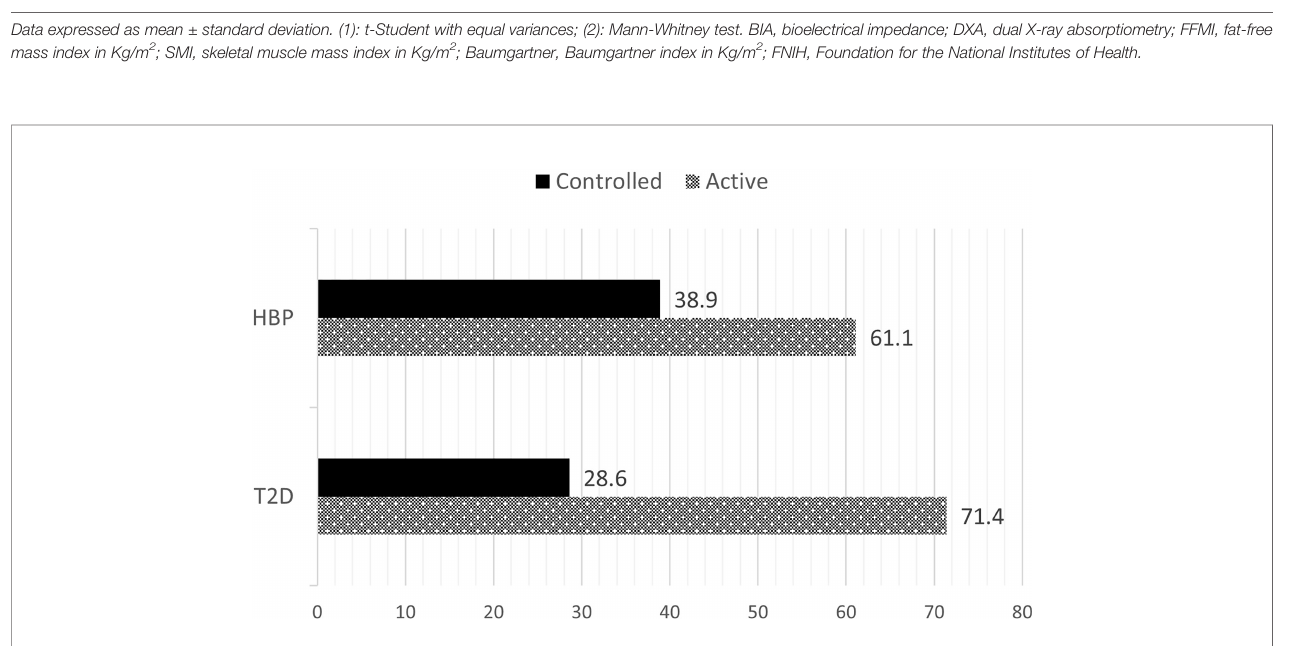
FIGURE 2 | Prevalence of diabetes and hypertension according to disease activity. HBP, high blood pressure; T2D, type 2 diabetes